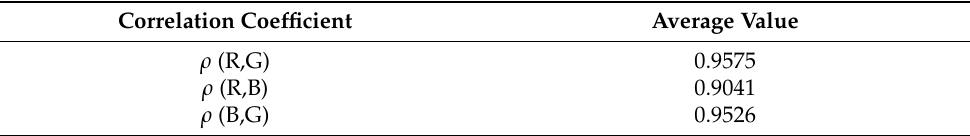
Table 1. Color components correlation coefficients of WCE images.